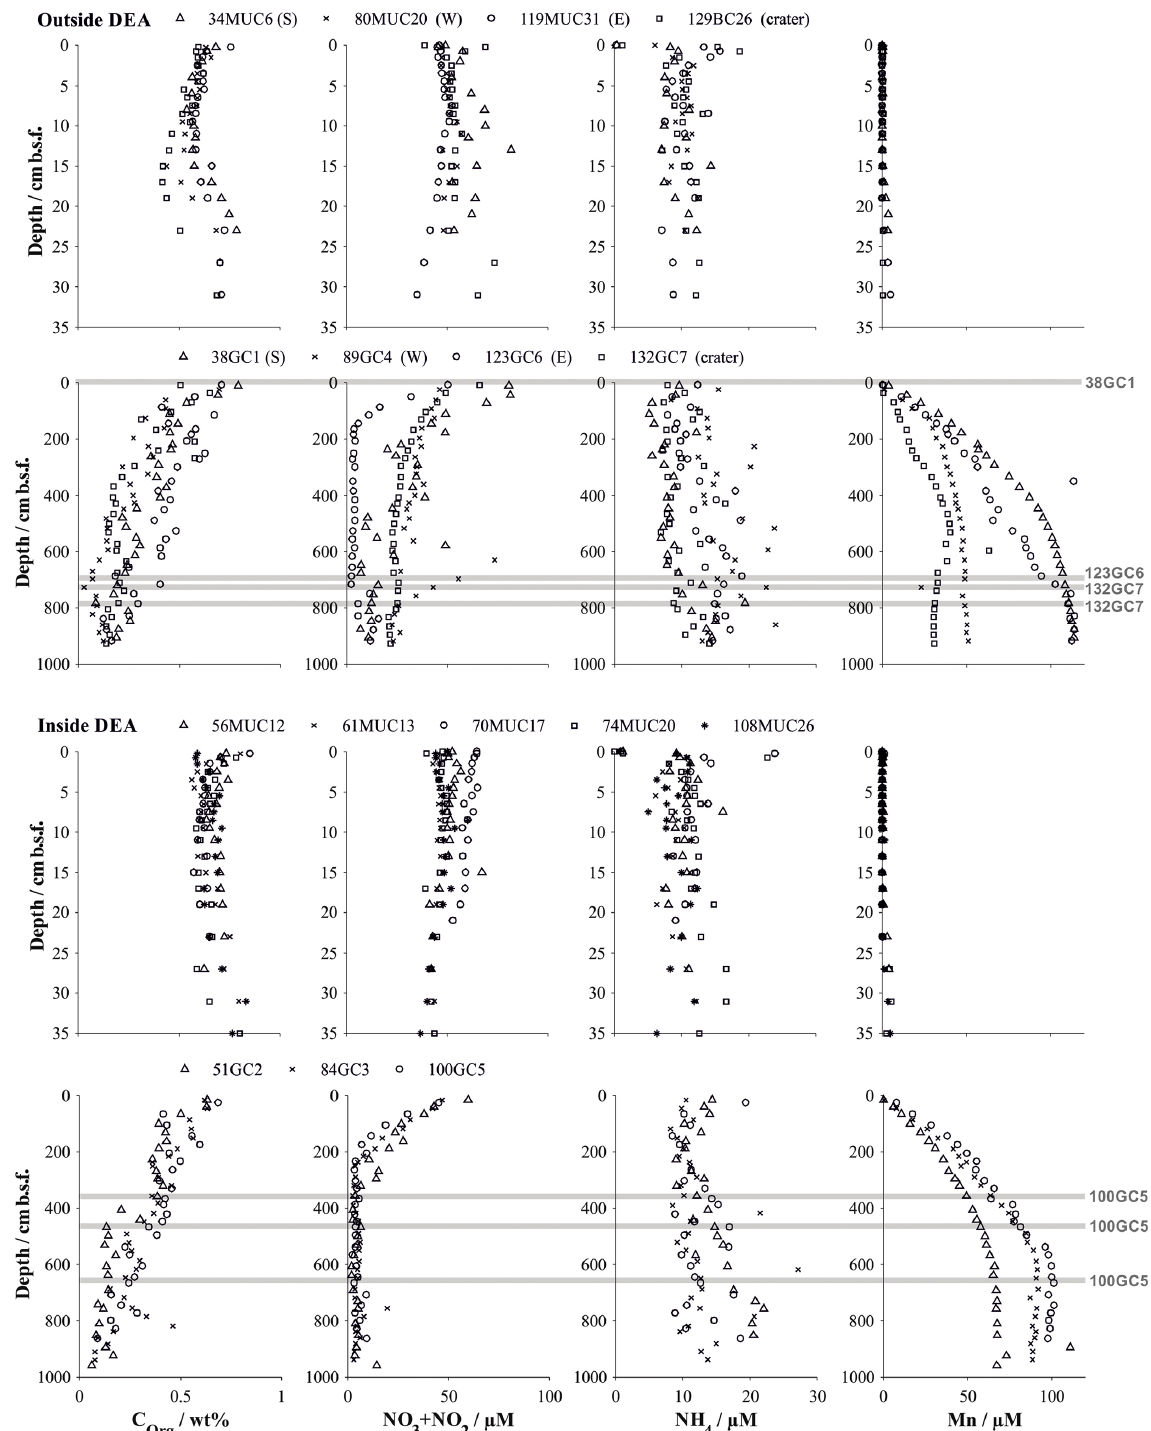
Figure 3. Organic carbon content (Paul et al., 2018, 2019) and dissolved solute profiles of summed NO 3 and NO 2 (Paul et al., 2018, 2019), NH 4 and Mn in gravity cores, and their corresponding multicores. Symbols represent the measured values at the mean depth of the sediment layer sampled. Buried manganese nodules are indicated by a grey line. Details on individual sampling stations can be found in Table